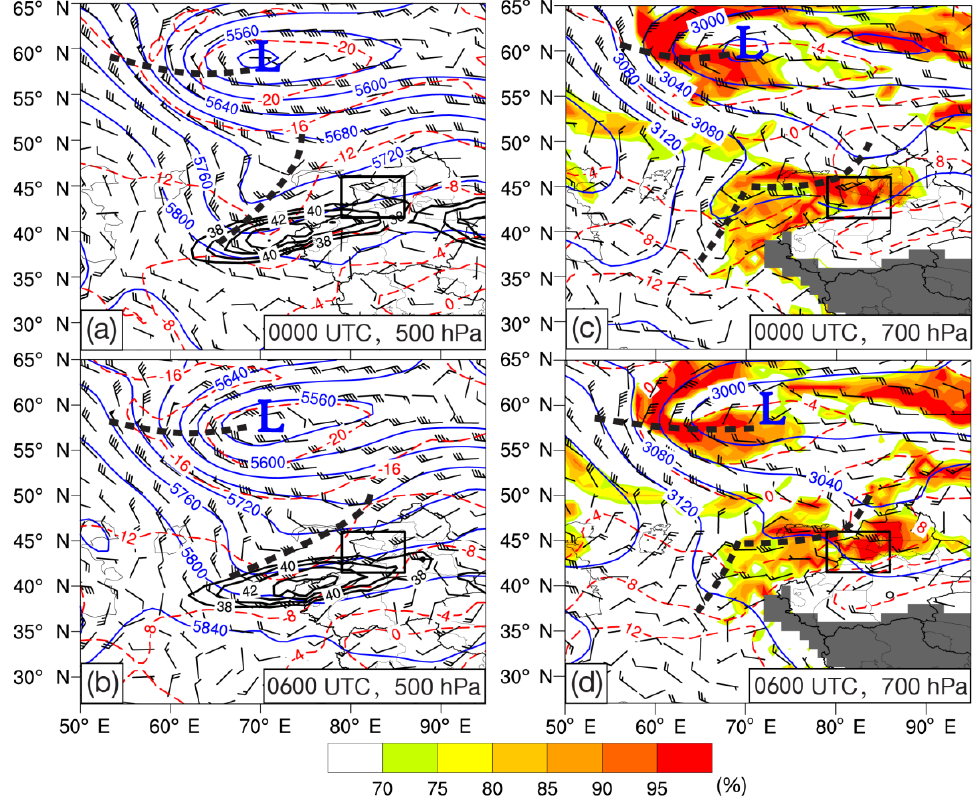
Figure 5. ( a – d ) Geopotential height (blue lines, units: gpm), temperature (red lines, units: °C), and wind fields (half barbs, full barbs, and flags represent 2, 4, and 20 m s − 1 , respectively) on 17 June 2016 derived from NCEP FNL data. The specific time and isobaric surface level are shown in the lower right corner of each panel. The overlaid black contours (unit: m s − 1 ) in ( a , b ) indicate the upper-level jet exceeded 38 m s − 1 at 200 hPa. The shaded color area in ( c , d ) represent the relative humidity (units: %) in excess of 70%, the dark grey shadings show the Tibet Plateau with ground pressure below 700 hPa. The thick black dashed lines indicate the trough, the small rectangle area in all panels denote the study area shown in Figure 1a. The letter “L” indicates the low-pressure